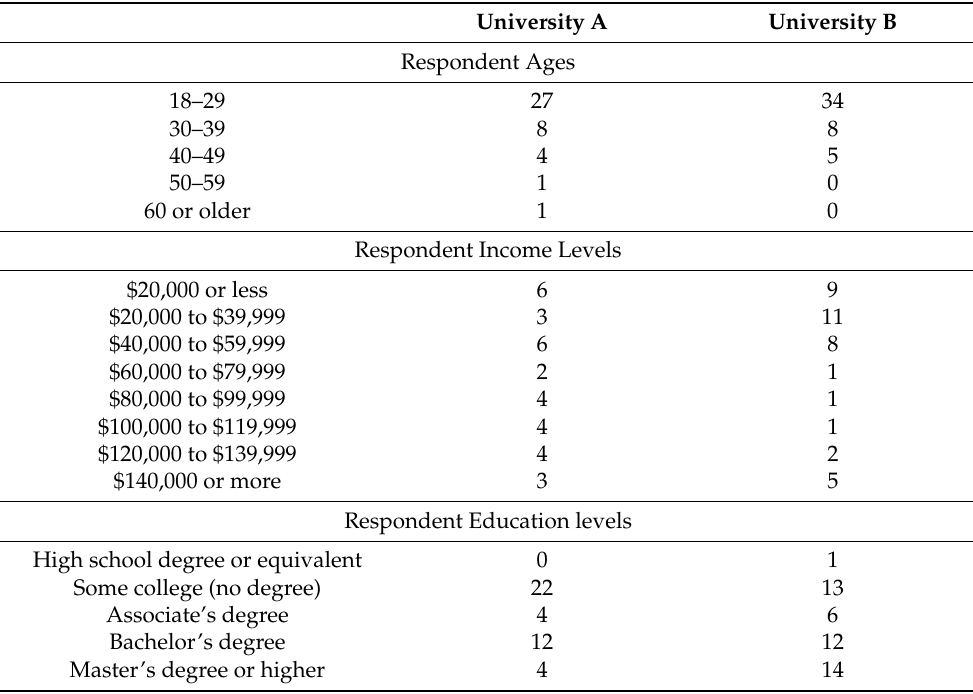
Table 1. Respondent demographics for survey